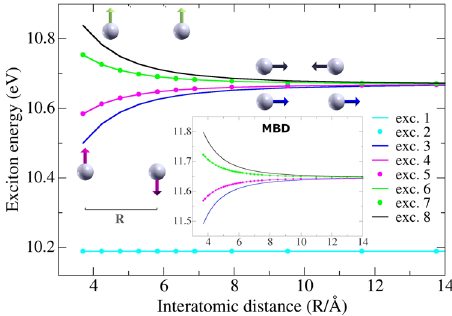
Fig. 1 Exciton energies in the hydrogen dimer. BSE excitation energies (i.e., energy required by the system to excite a given optical mode) are reported as a function of the interatomic separation R (MBD excitation energies are shown as inset). The fi rst two BSE excitation modes (cyan) correspond to 1 s → 2 s transitions and undergo no dipolar splitting due to their spherical symmetry. BSE excitations 3 – 8 instead correspond to 1 s → 2 p transitions (degenerate only in the limit of vanishing interatomic coupling), and exhibit growing splitting at short interatomic distance. Optical vdW forces for a given excitation mode correspond to the inverse of the exciton-energy gradient. Gray balls schematically indicate atoms, while arrows (whose colors replicate the corresponding energy curves) give intuitive description of the correlation arising between dipolar displacements in the two H atoms. In excitons 3 and 8 (blue and black, respectively), atomic dipole modes are oriented along the direction joining the two atoms. Parallel dipoles (exc. 3) imply attractive coupling, while repulsion is found when the two dipoles are antiparallel, in analogy to the electrostatic case. Similar mechanisms arise in excitons 4 – 7, where dipole moments are instead oriented orthogonally to the H – H